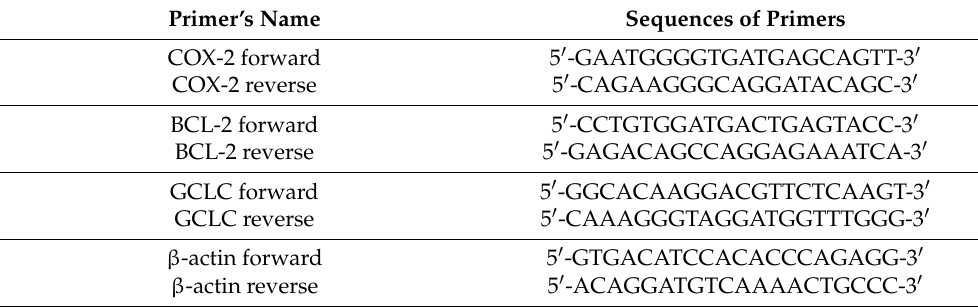
Table 1. The primer sequence of target genes and housekeeping